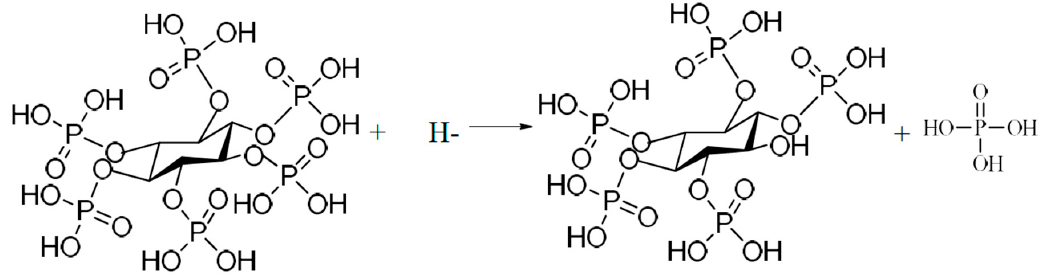
Figure 9. The first hydrolysis step of phytic acid during MAO.